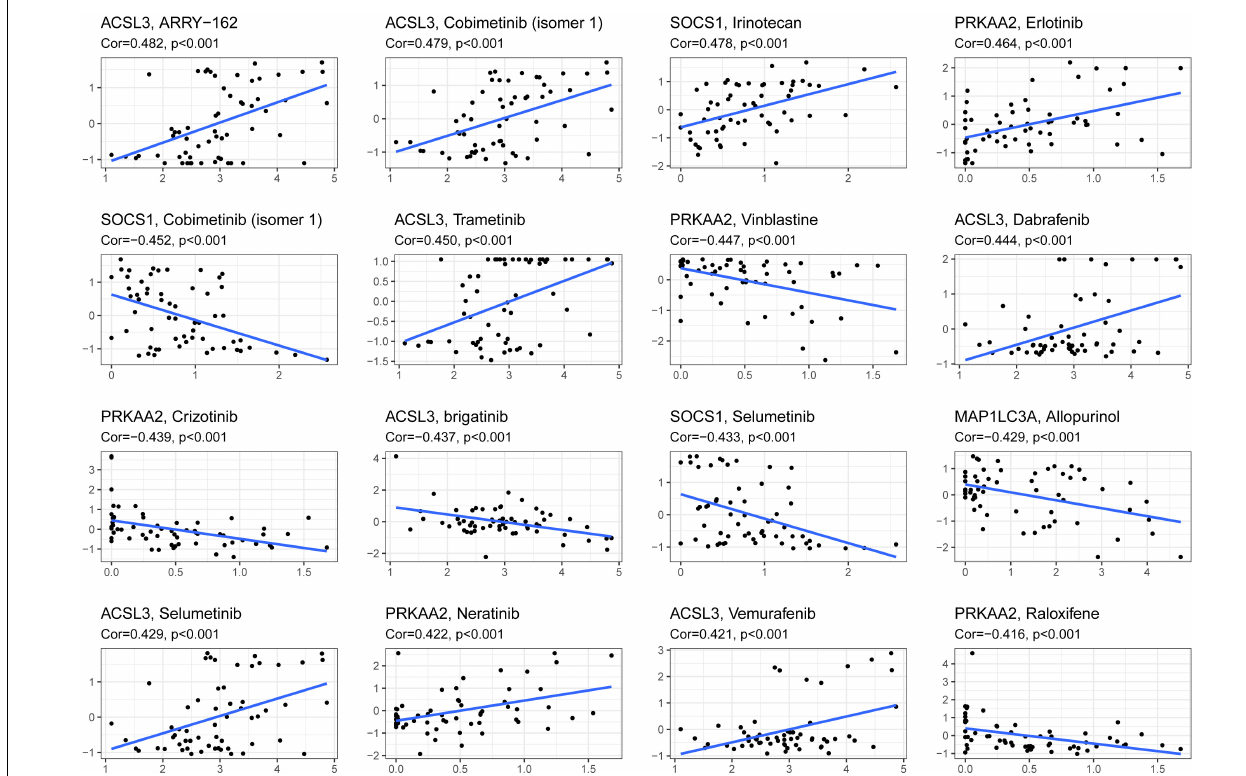
FIGURE 7 | The correlation between ferroptosis-related genes to construct the prognostic model and drug